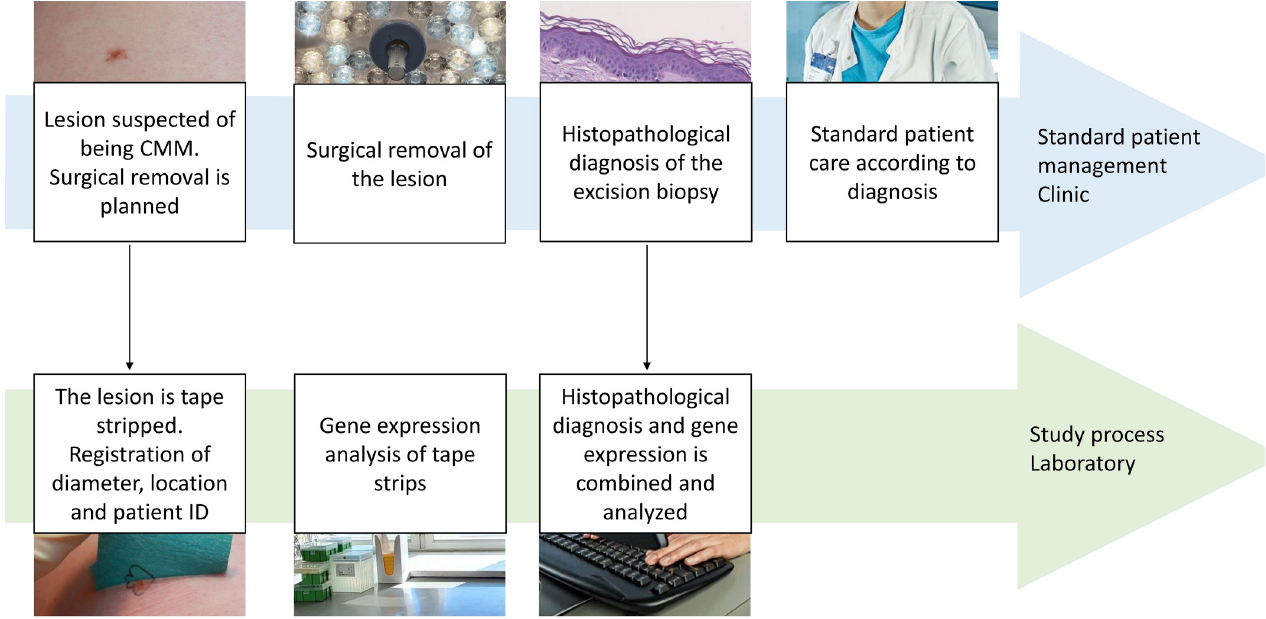
Fig 1. Study process. Overview of the standard patient management and study process initiated after obtaining written informed consent. During the study process, gene expression is investigated through RNA profiles on tape strips. The two black arrows indicate the transfer of data or material from the clinic to the project. No data is transferred from the project to the clinic. Clinical patient management is unaffected by the study and takes place without delay. Abbreviations: CMM: cutaneous malignant melanoma, patient ID: unique Danish personal identification number.